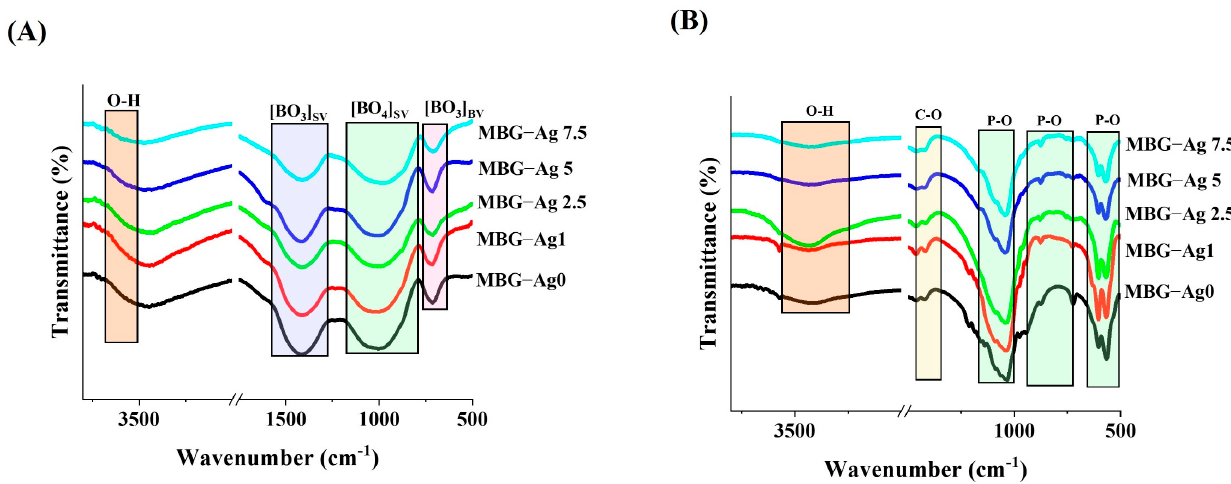
Figure 5. FTIR spectra of the Ag-free and Ag-doped MBGs before ( A ) and after immersion in SBF ( B ).